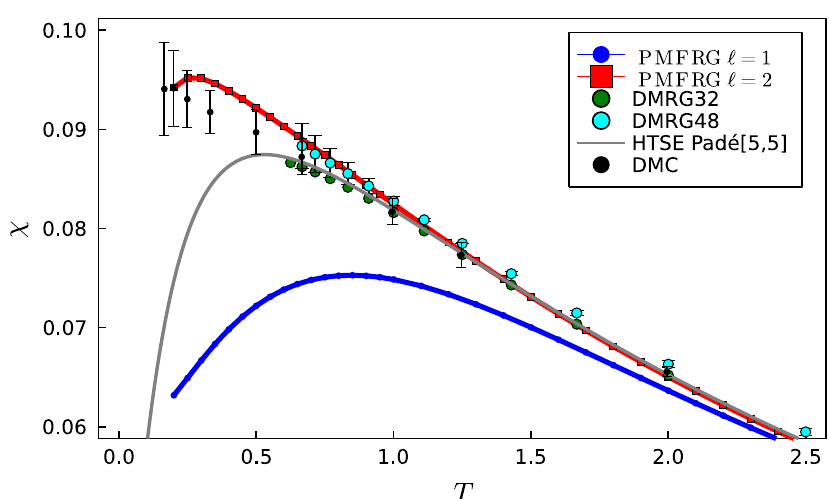
Figure 4: Uniform ( q = 0) susceptibility for the pyrochlore antiferromagnet from PMFRG as a function of temperature in comparison with diagrammatic Monte Carlo (DMC) [ 49 ] , density-matrix renormalization group [ 44 ] (DMRG, cluster sizes 32 and 48) and the Padé approximant of the high temperature series expansion [ 50 ]